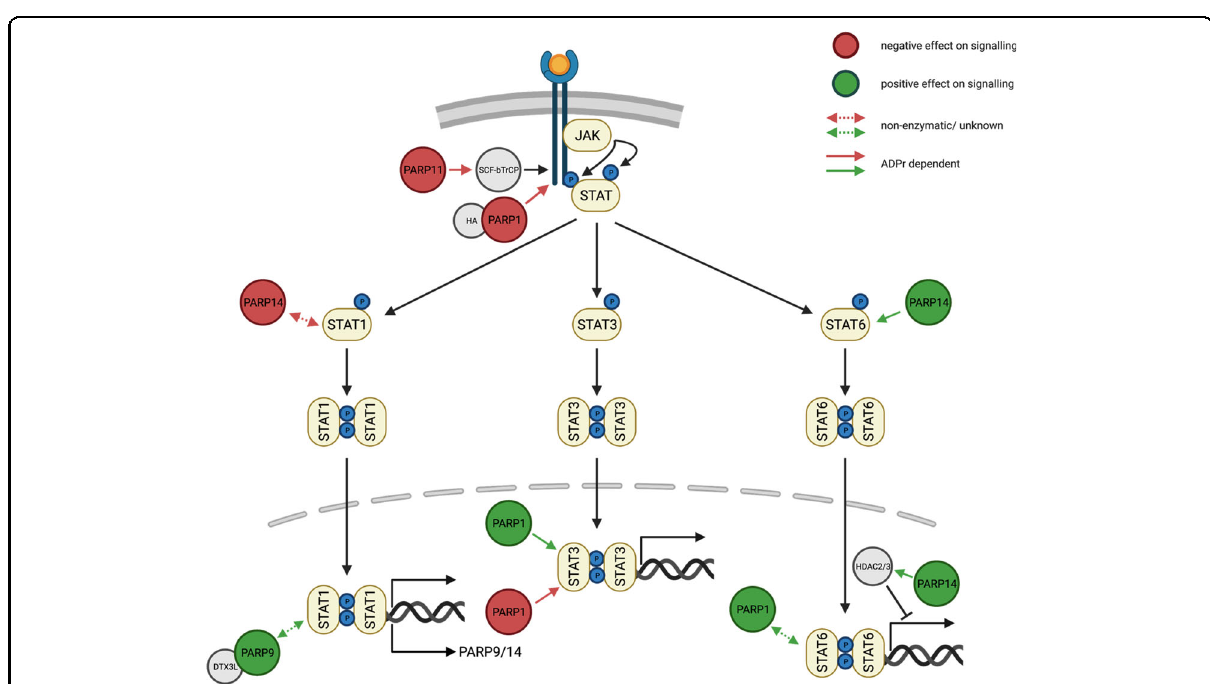
Fig. 2 Schematic overview of the interplay between JAK/STAT signaling and ARTD family members. Positive regulations of JAK/STAT signaling by ARTD family members are depicted in green, while negative effects of ARTDs on the signaling pathway are shown in red. Solid lines indicate the contribution of ADP-ribosylation to the regulation of JAK/STAT signaling. In case the contribution of ADP-ribosylation was not described or the protein itself rather than its enzymatic activity is involved in the regulation, the interactions are represented by dashed